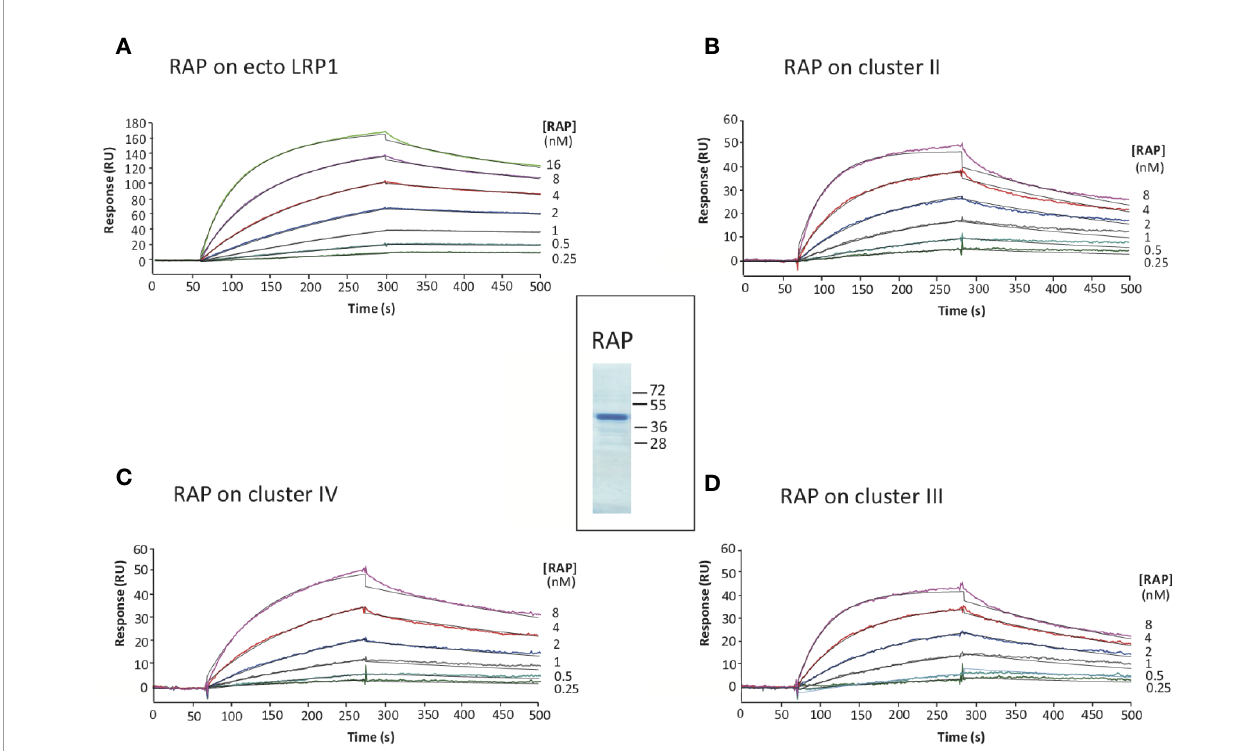
FIGURE 3 | Kinetic analysis of RAP interaction with immobilized full-length LRP1 and clusters II, III and IV. SDS-PAGE of RAP in reducing conditions, molecular weight markers are indicated in kDa (center panel). SPR analysis of RAP interaction with full-length LRP1: RAP was injected at indicated concentrations over immobilized full-length LRP1 ( A , 7,400 RU), and LRP1 clusters II ( B , 2,967 RU), III ( D , 3,460 RU) and IV ( C , 3,396 RU) in 50mM triethanolamine-HCl (TEA), 145mM NaCl, 1mM CaCl